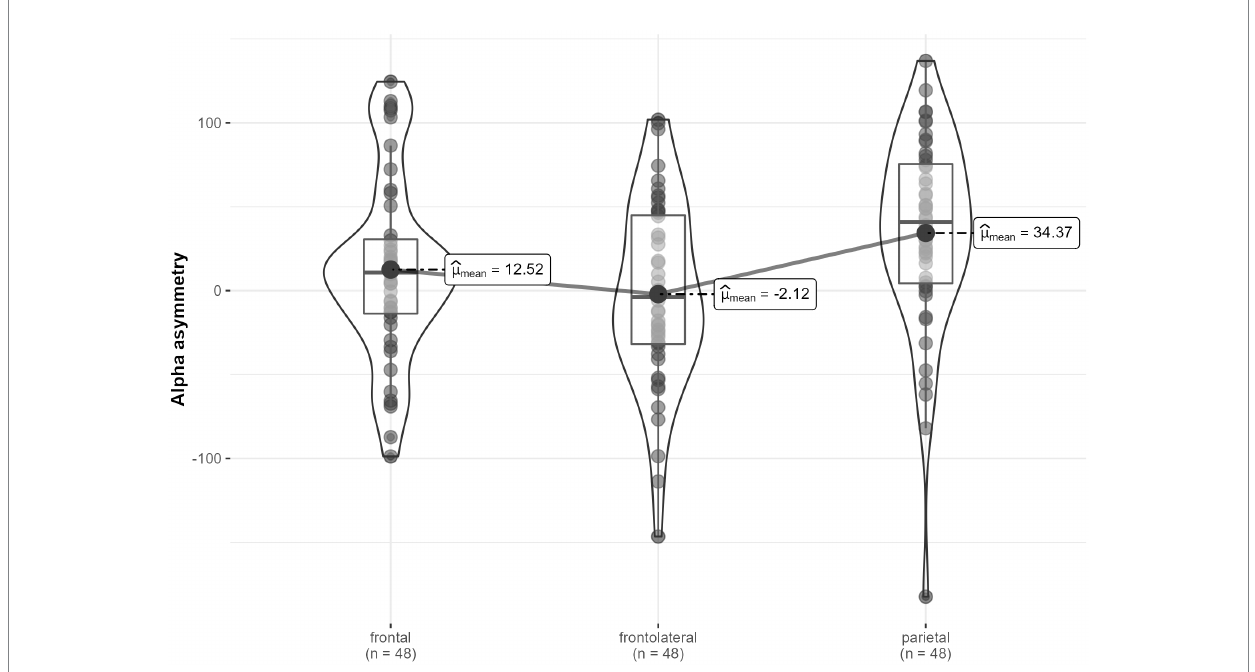
FIGURE 6 Alpha asymmetry in three locations (frontal, frontolateral and parietal), across conditions.